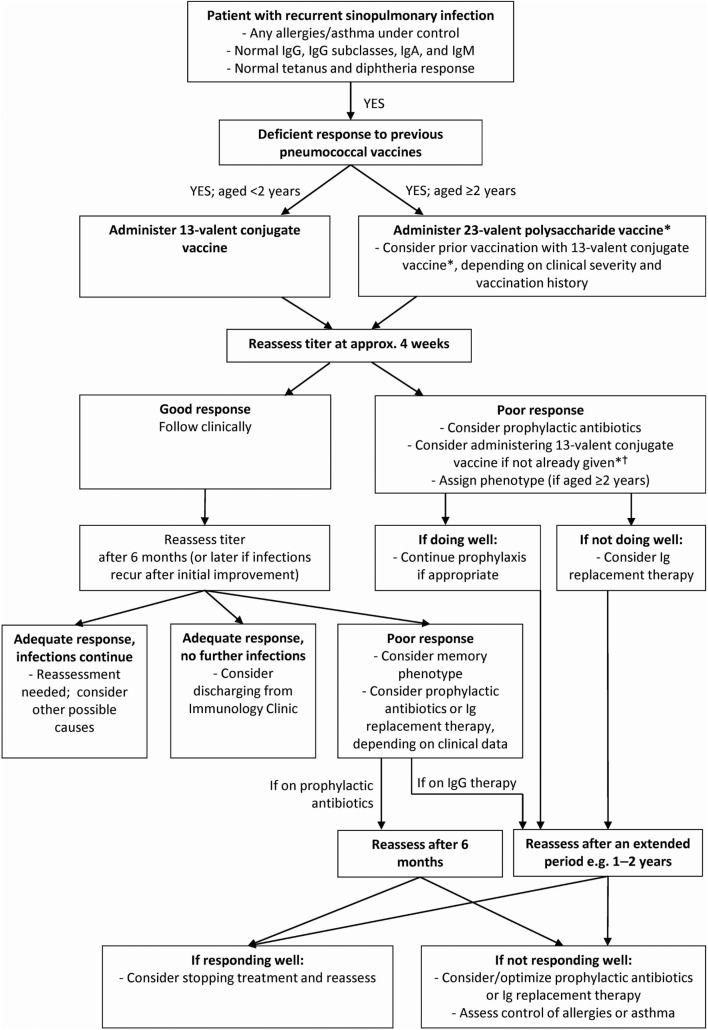
Diagnosis and treatment algorithm for specific antibody deficiency (SAD). *The Centers for Disease Control and Prevention recommend that when both 23-valent pneumococcal polysaccharide vaccine (PPSV23) and 13-valent pneumococcal conjugate vaccine (PCV13) are indicated, PCV13 should be given before PPSV23 whenever possible. In adults PPSV23 should be given ≥8 weeks after previous doses of PCV13 and PCV13 should be given ≥1 year after the most recent dose of PPSV23. In patients 19–64 years of age PPSV23 may be revaccinated ≥5 years after last vaccination. In patients aged ≥65 years PPSV23 may be revaccinated once if ≥5 years after vaccination at<65 years of age. Additional doses of PCV13 should not be administered in patients ≥65 years. For further details of vaccination schedules, please refer to reference (28). †Normal responses to PCV13 do not preclude diagnosis of SAD (12).